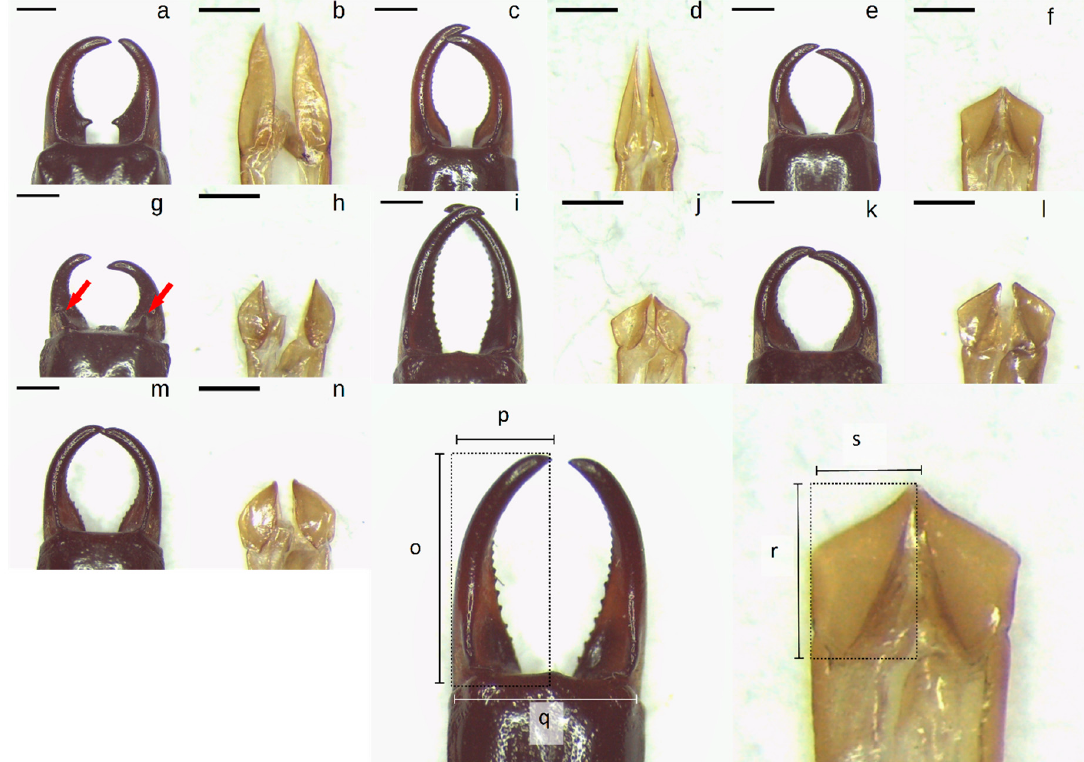
Figure 1. ( a–n ): Photos of male Anisolabididae forceps and parameres. ( a , b ): Anisolabis sp. 1. ( c , d ): Anisolabis sp. 2. ( e , f ): Gonolabis forcipata Burr. ( g , h ): Gonolabis nr. gilesi Steinmann. ( i , j ): Gonolabis sp. 1. ( k , l ): Gonolabis sp. 2. ( m , n ): Gonolabis sp. 3. ( o–s ): Diagrams of morphometric measurements taken. ( o ): Forceps length. ( p ): forceps width. ( q ): basal width of forceps. ( r ): paramere length. ( s ): paramere width. All scale bars indicate 1 mm. Red arrows indicate location of dorsoventrally oriented teeth on forceps of male G. nr. gilesi .